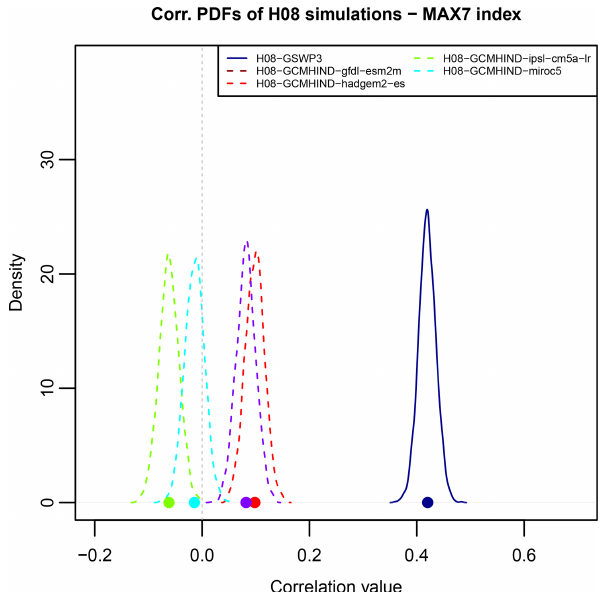
Figure 4. Model–observation correlation between observed trends and simulated trends across all simulations (GSWP3 and four GCMHIND simulations) of a single model (H08; similar results for other GHMs). Coloured dots indicate actual correlation between a specific simulated trend pattern and observed trend pattern across 3666 locations. Colour lines represent the PDFs of correlation be- tween simulated trend pattern and observed trend pattern obtained through a bootstrap resampling procedure ( B = 2000).